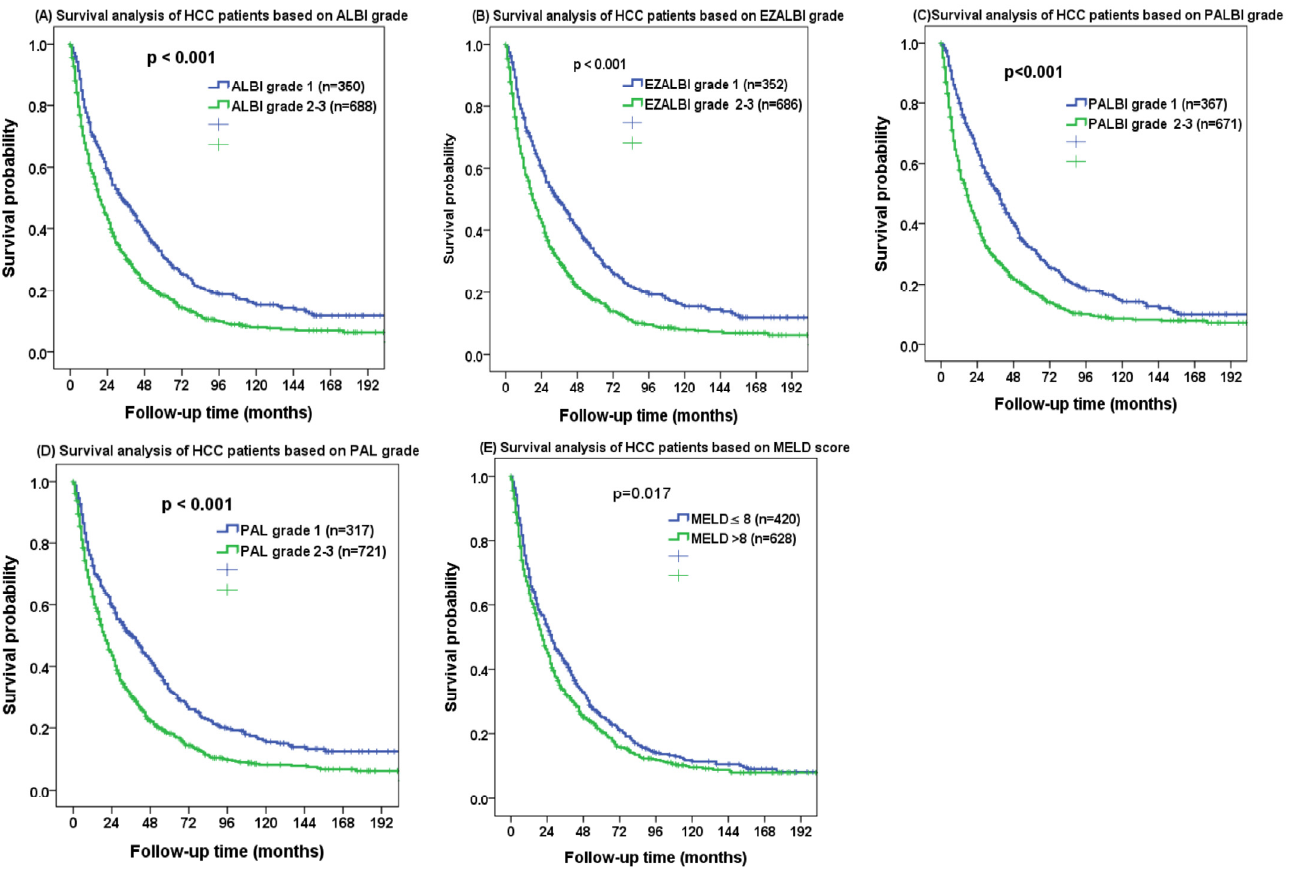
Figure 2. Kaplan–Meier survival analysis of HCC patients undergoing transarterial chemoembolization (TACE) based on ( A ) ALBI grade, ( B ) EZ-ALBI grade, ( C ) PALBI grade, ( D ) PAL grade and ( E ) MELD score.